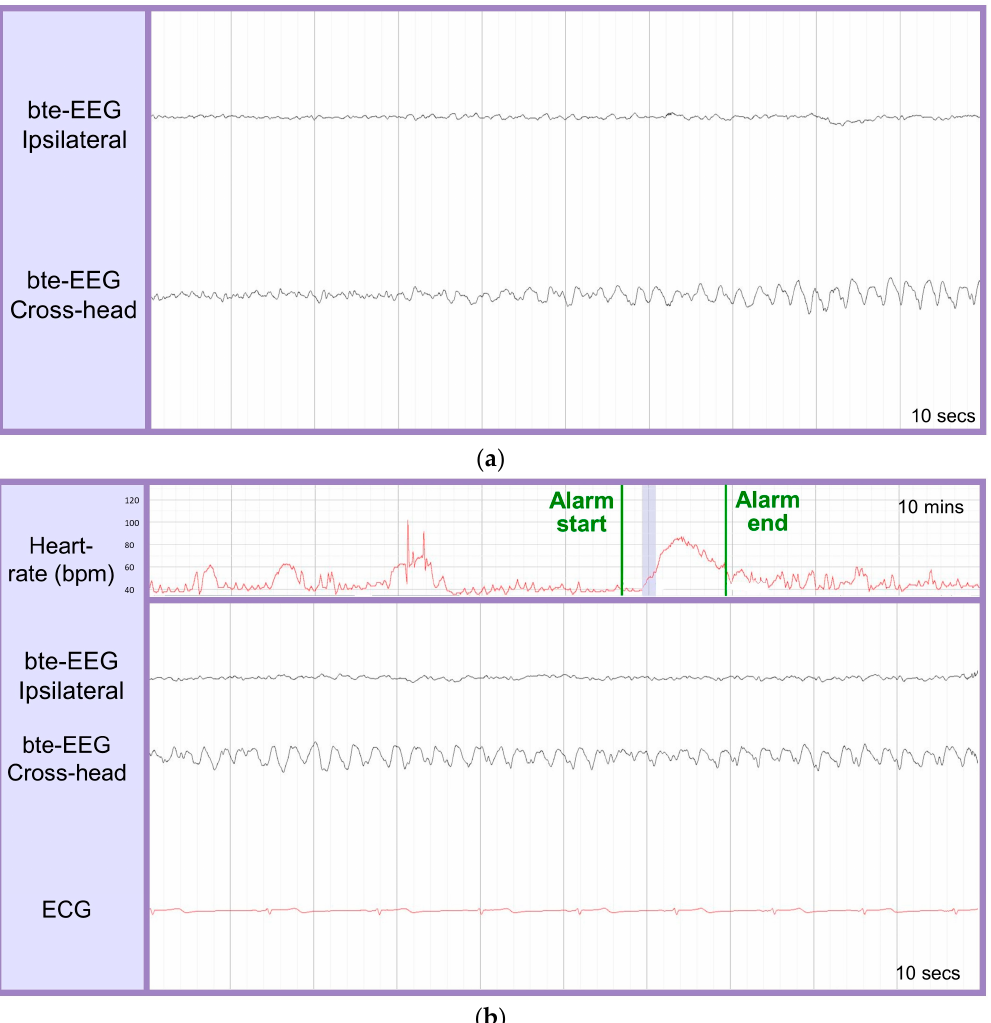
Figure 2. Presentation setup for the two visual experiments: ( a ) setup for visual annotation of the bte-EEG data; ( b ) setup for visual annotation of the bte-EEG and ECG data. In ( a , b ), the black time-series corresponds to the ipsilateral (top) and cross-head (bottom) bte-EEG channel. In ( b ), the top red signal corresponds to the heart rate derived from ECG, and the bottom red signal shows the raw ECG data. The heart rate data are presented in a 10 min window, and the other signals in a 10 s window. The green vertical lines indicate the start and end of the detected seizure, and the purple shaded area on the heart rate plot depicts the 10 s window presented in the bte-EEG and ECG plot.